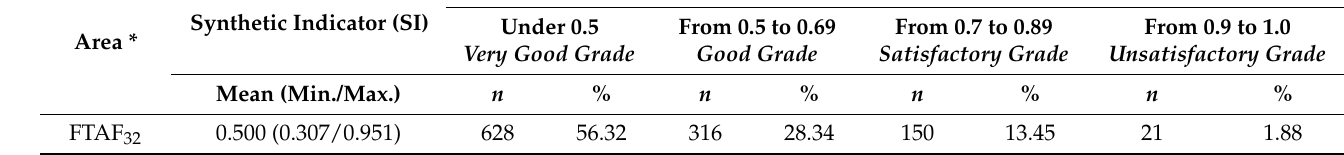
Table 4. The mean value of the synthetic indicator (SI) for the frequency of throwing away 32 different food products (FTAF 32